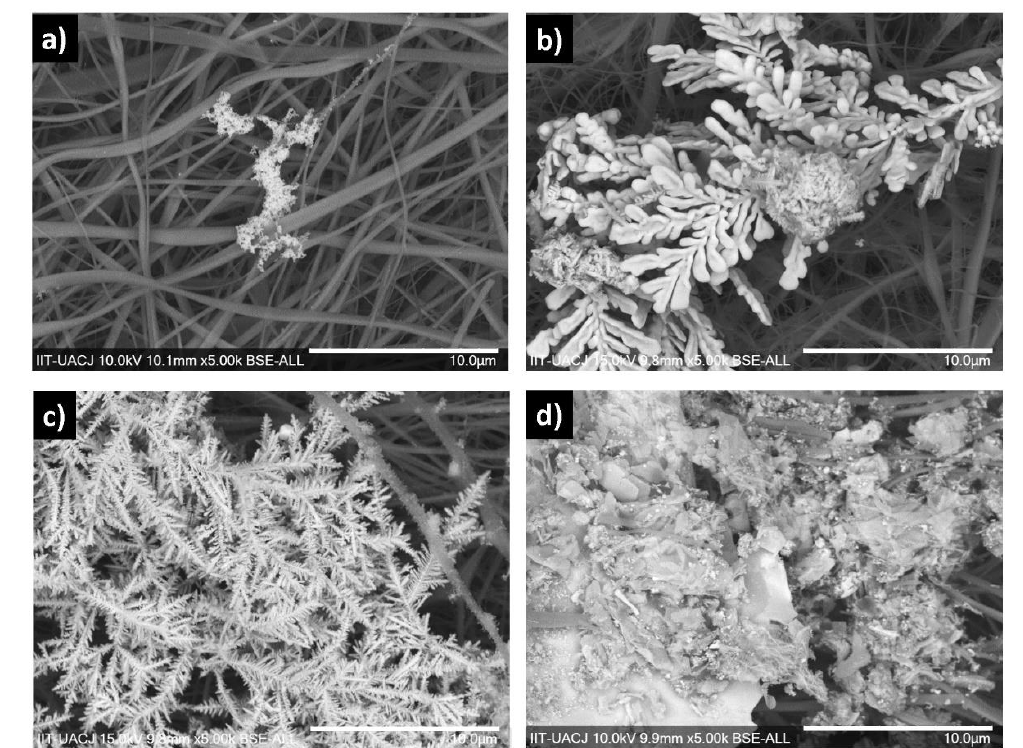
Figure 5. SEM micrographs of silver-doped fibers at 20 mM AgNO 3 during: ( a ) 1, ( b ) 2, ( c ) 5 and ( d ) 10 min.